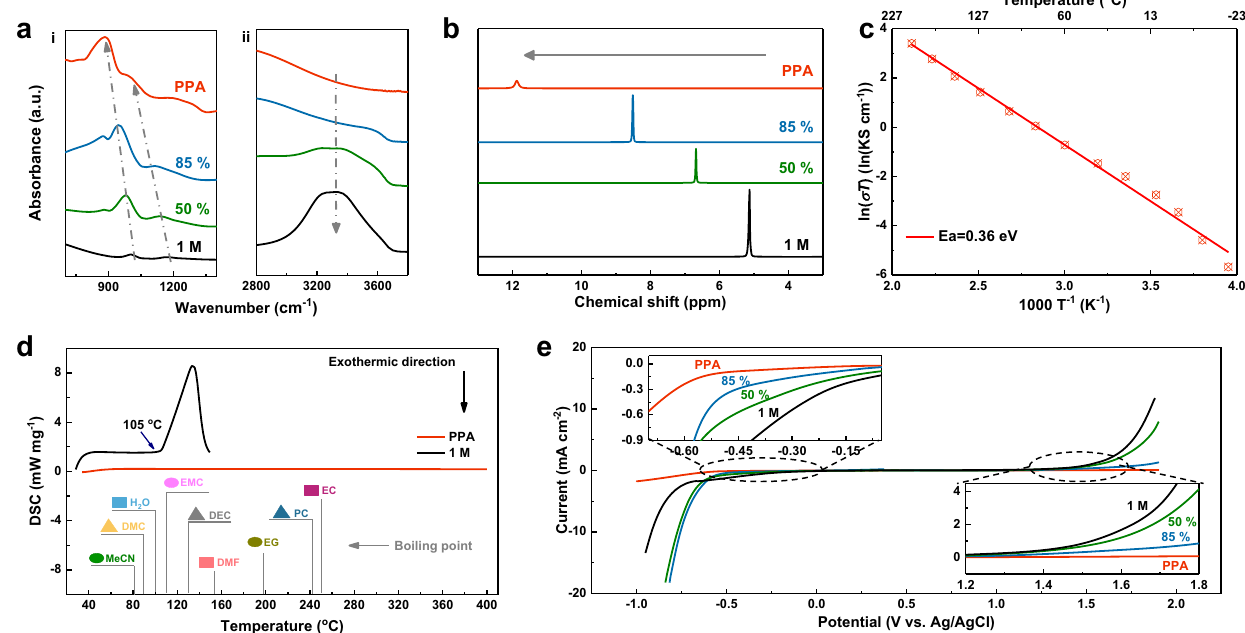
Fig. 1 | Thecomparisonof various H 3 PO 4 electrolytes.a ATR-FTIR and b 1 H NMR spectraof1MH 3 PO 4 ,50wt%H 3 PO 4 ,85wt%H 3 PO 4 andPPA. c TheArrheniusplotof PPA electrolyte. d DSC of the 1M H 3 PO 4 and PPA electrolyte. The boiling points of